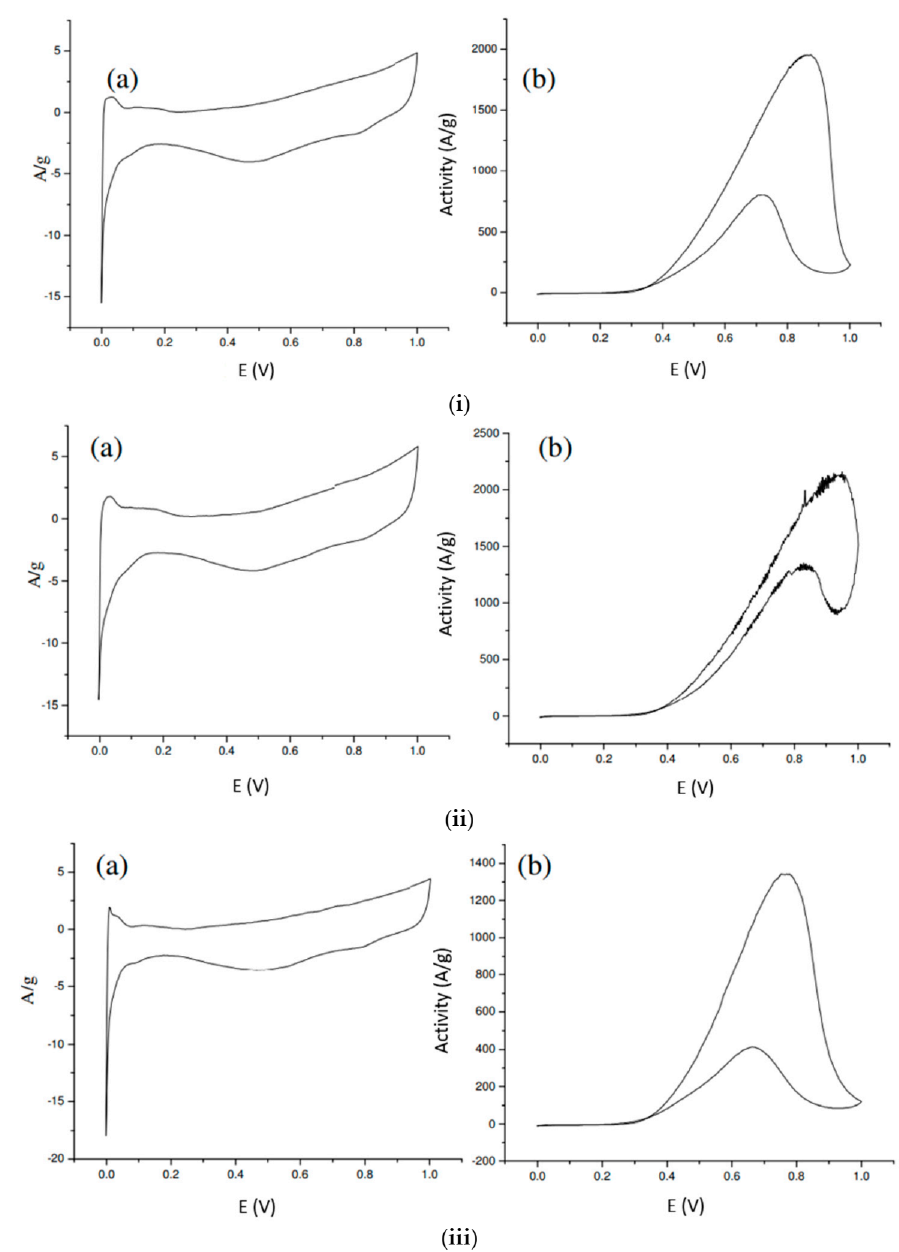
Figure 7. CV plot of the sample. ( i ) Sample PtRu/carbon-01; ( ii ) Sample PtRu/carbon-02; ( iii ) Sample PtRu/carbon. ( a ) background of the 10th cycle, ( b ) activity of the 10th cycle. The unmodified and modified carbon black were used as the supports. 60